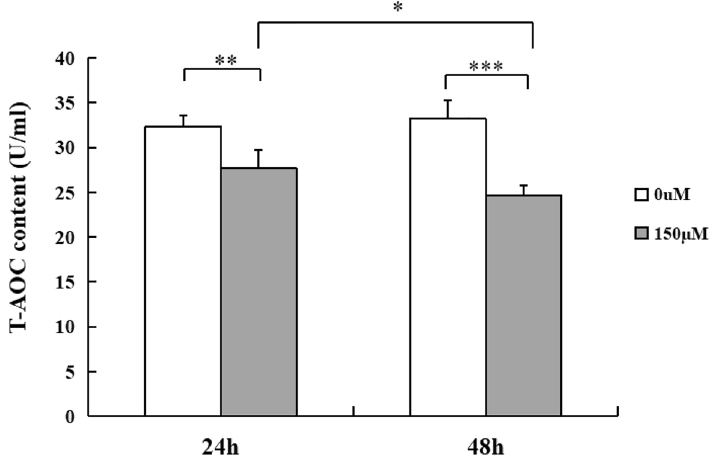
Figure 3. H 2 O 2 treatment inhibits T-AOC content of MECs. T-AOC content of MECs was decreased after cells were exposed to H 2 O 2 (150 µM) for 24 h and 48 h respectively compared with untreated cells. Data are represented as mean ± SD (n = 6) * p < 0.05, ** p < 0.01, *** p < 0.001. MECs, meningothelial cells; T-AOC, total antioxidant capacity.